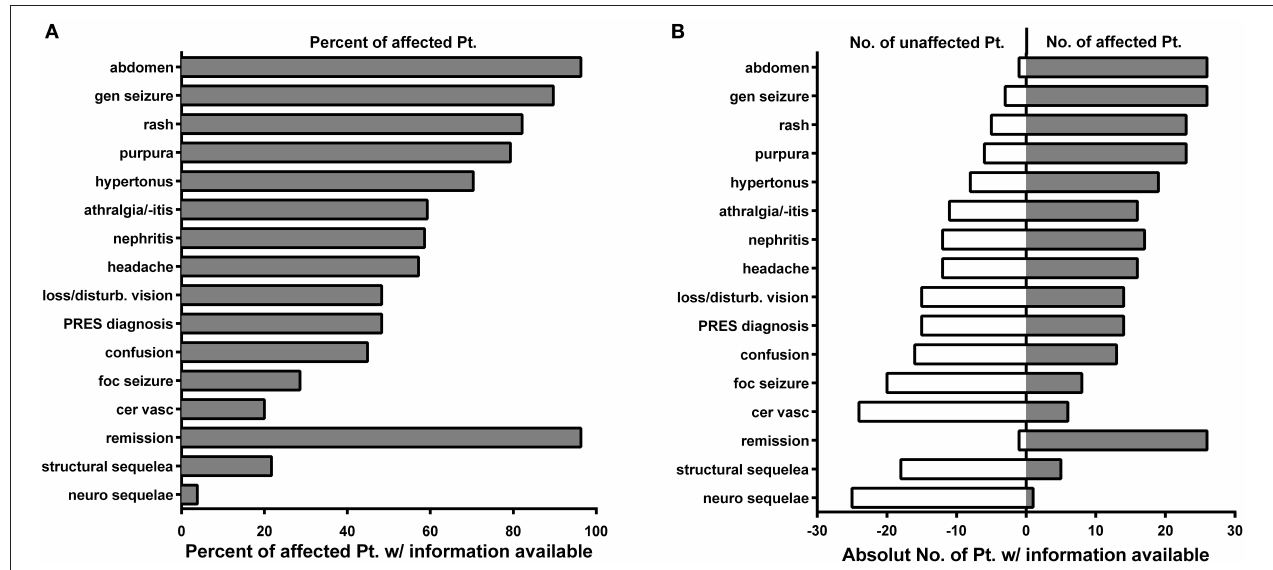
FIGURE 4 | The clinical phenotype of IgAV-patients in this cohort (A) Fraction of affected patients relative to the whole cohort of patients of whom information was available with different clinical manifestations depicted on the Y-axis. (B) Absolute numbers of patients who are not affected by different clinical manifestations are depicted on the left (open white bars), while the absolute number of reported patients affected are depicted to the right side (solid gray bars). gen. seizure, generalized seizure; loss/disturb. vision, loss/disturbed vision; foc. Seizure, focal seizure; cer. vasc., cerebral vasculitis; neuro sequelae, neurological sequelae.